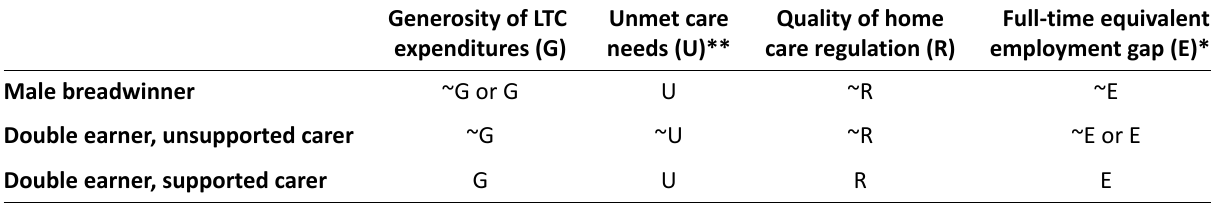
Table 1. Property space of LTC policy ideal